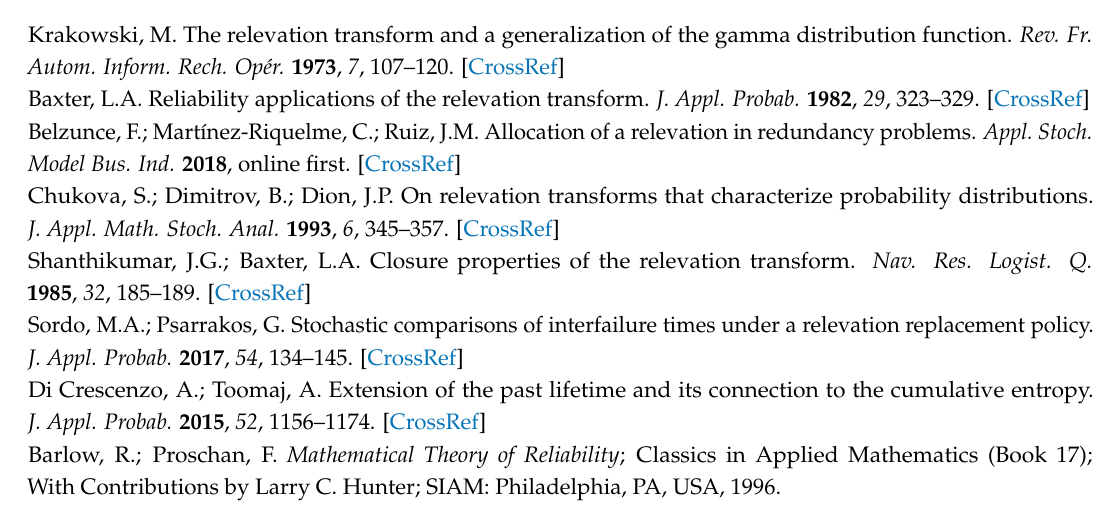
Figure 4. With reference to Example 3, plot of H (from bottom to top). Right : µ = 2 and h = 2, 3, 4, 5 (from top to